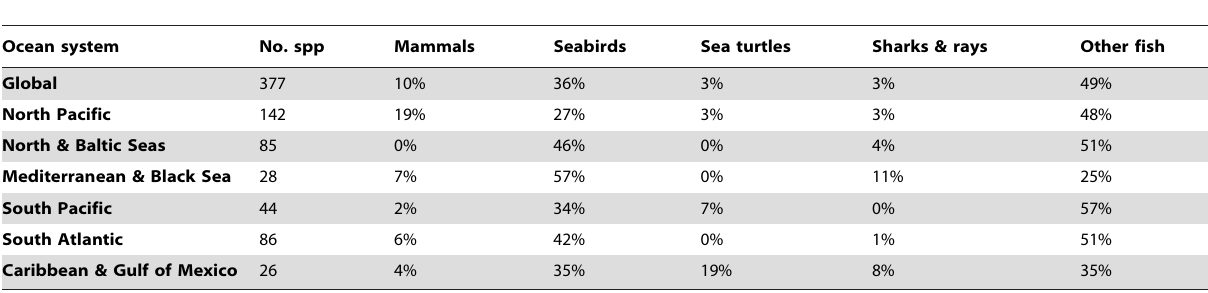
Table 2. The modelled species groups used to calculate the LPI for each region.